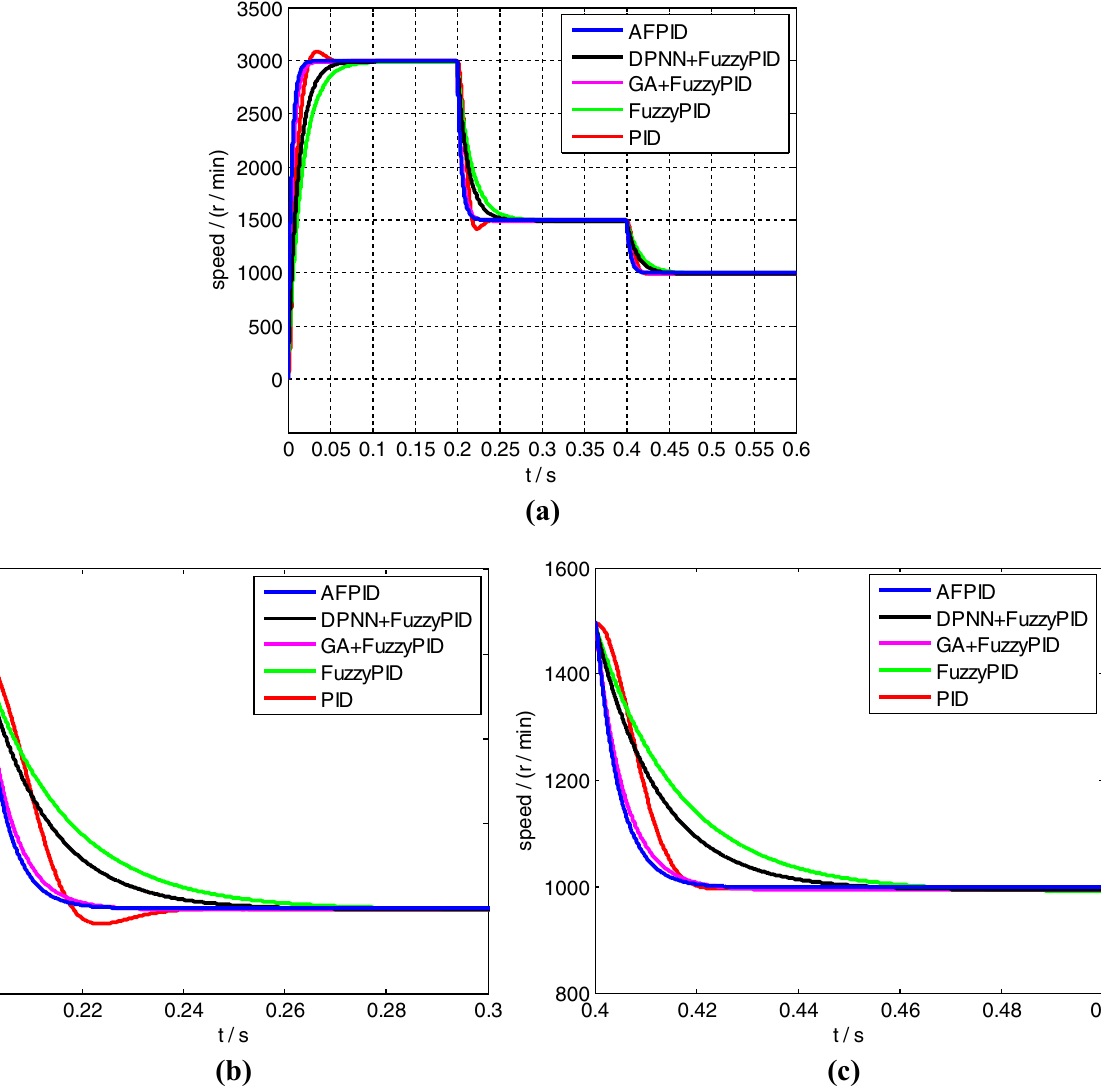
Fig. 10 The comparison of speed tracking with no load: a speed response curve of 0–0.6 s, b transient speed response curve of 0.2–0.3 s c transient speed response curve of 0.4–0.5 s